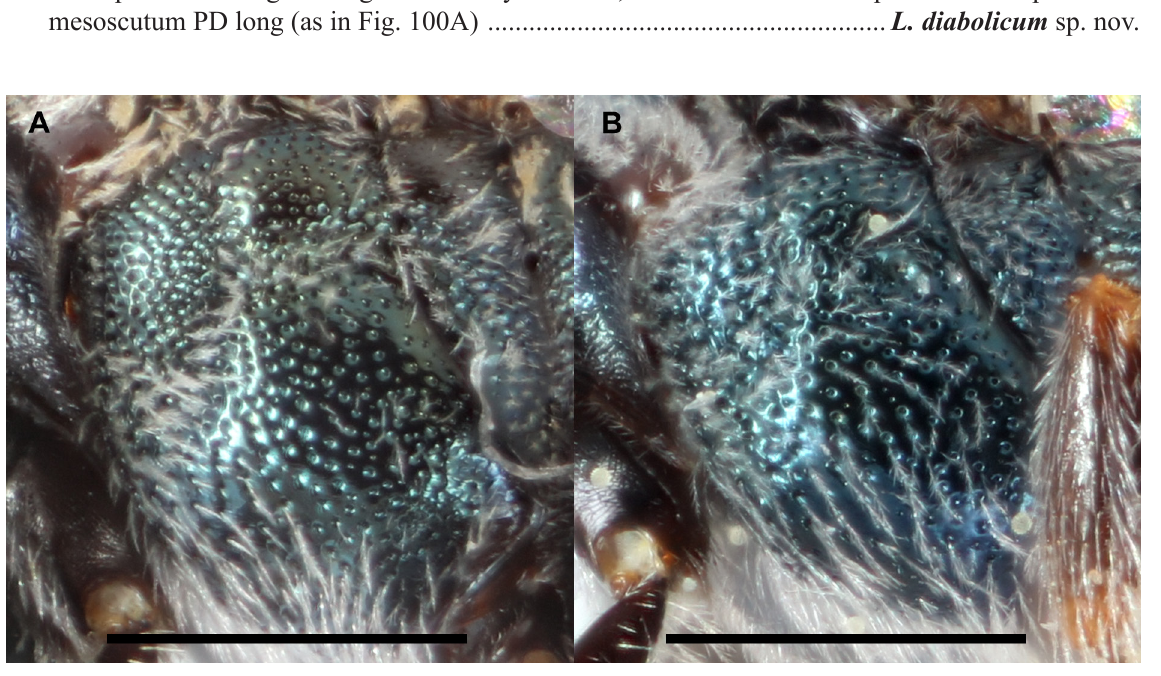
Fig. 119. Pleura. A . Lasioglossum lepidii (Graenicher, 1927), ♂, preëpisternum and hypoepimeron more finely punctate than mesepisternum. B . L. diabolicum sp. nov., ♂, preëpisternum and hypoepimeron as coarsely punctate as mesepisternum. Scale bars = 0.5 mm.